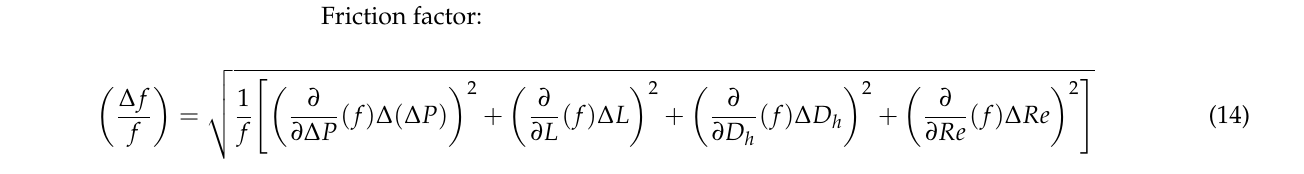
Table 2. Accuracy of Measurement Instruments.